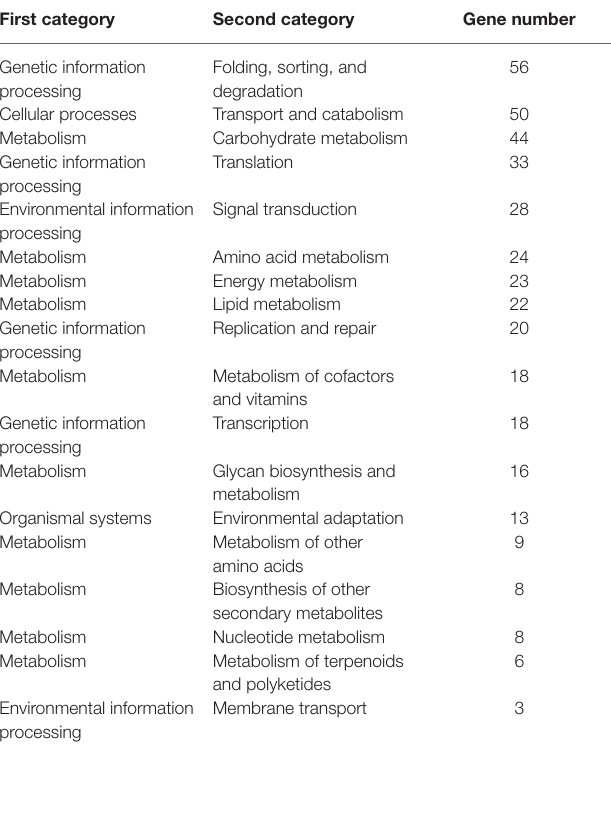
TABLE 2 | KEGG pathway statistics of genes in